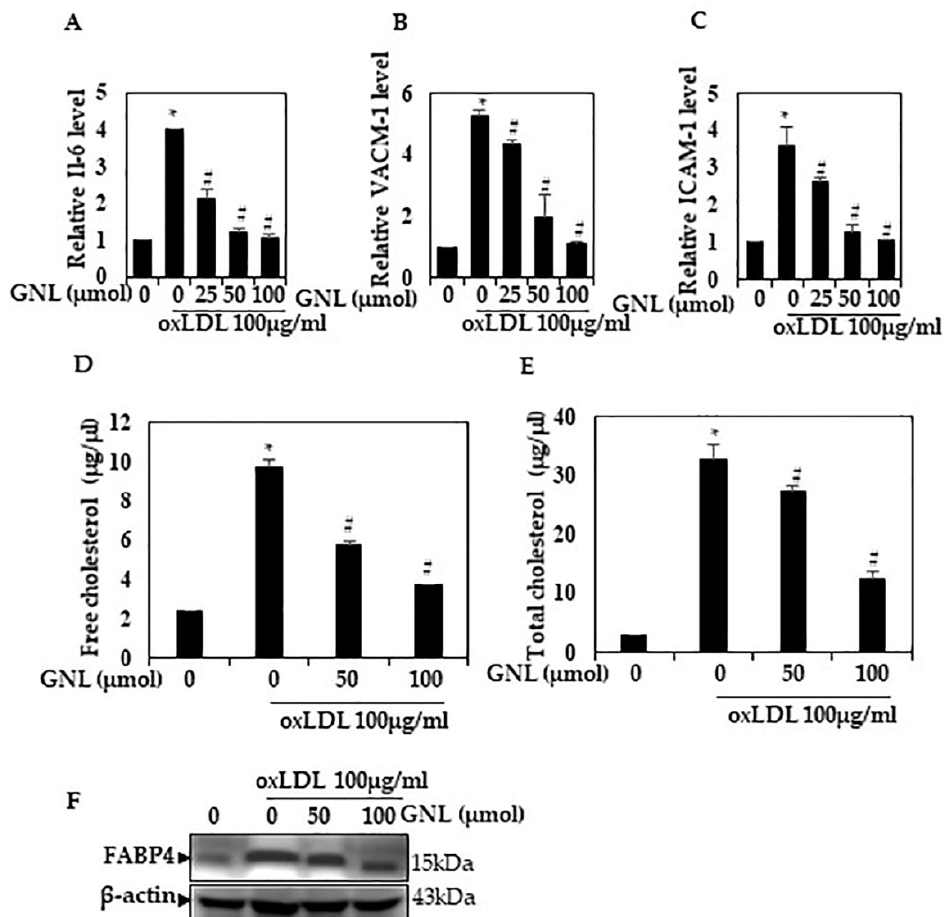
Figure 4. Effect of GNL on Ox-LDL-induced deposition of cholesterol in HUVECs. ( A – C ) RT-PCR quantification of pro-inflammation cytokines IL-6 and ICAM-1 and adhesion molecule ICAM-1. ( D ) Free cholesterol (FC); ( E ) Total cholesterol (TC). ( F ) Quantification of fatty acid-binding protein 4 (FABP4) activation by Western blot analyses. There are three replicates of each value, and * represents p < 0.05; thus, a significant difference when compared to the control group. The # represents p < 0.05; thus, significant differences between the Ox-LDL alone and GNL with Ox-LDL treatment groups.